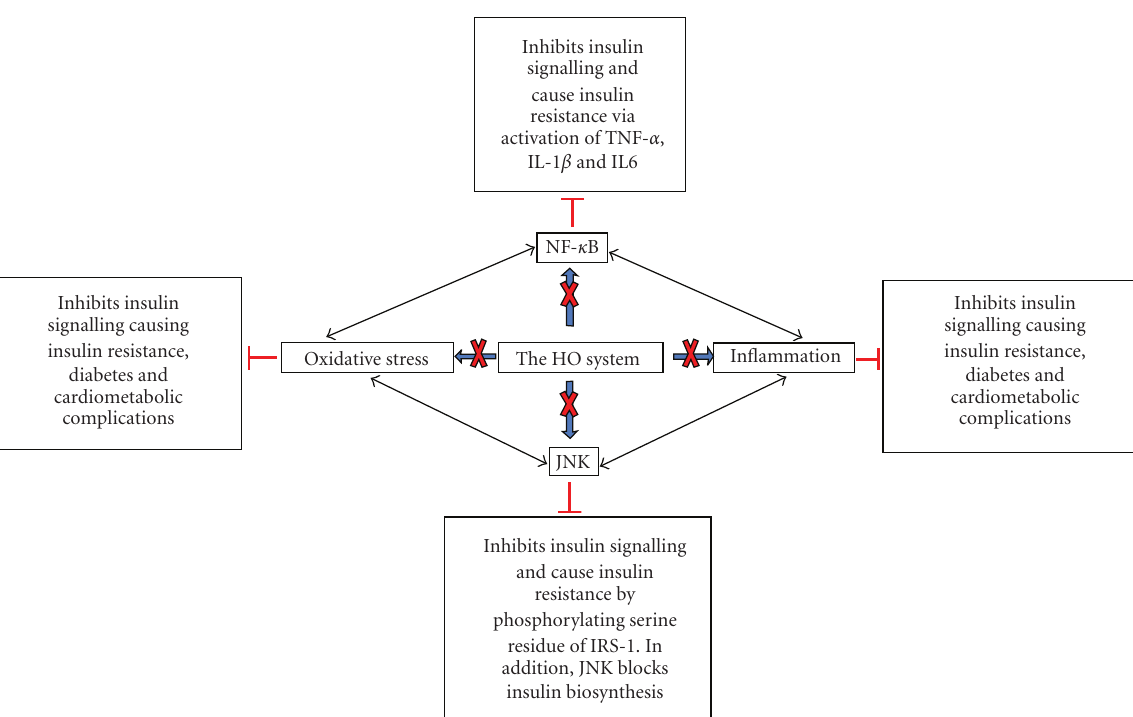
Figure 2: Schematic representation illustrating the protective role of the HO system in glucose metabolism . Inflammatory and oxidative mediators like NF- κ B, JNK, TGF- α , IL1 β and IL-6 are amongst the pathophysiological factors that impair insulin signalling. Generally these substances stimulate oxidative/inflammatory events destroying tissue. Conversely, other factors including cytokines and inflammatory/oxidative transcription factors like NF- κ B, JNK stimulate a variety of di ff erent pathophysiological pathways to further aggravate oxidative/inflammatory insult, creating a vicious cycle of intense inflammation that would severely damage tissue and compromise many physiological functions including glucose metabolism. However, the HO system suppresses these inflammatory/oxidative mediators and pro-inflammatory cytokines to enhance insulin signalling and improve glucose